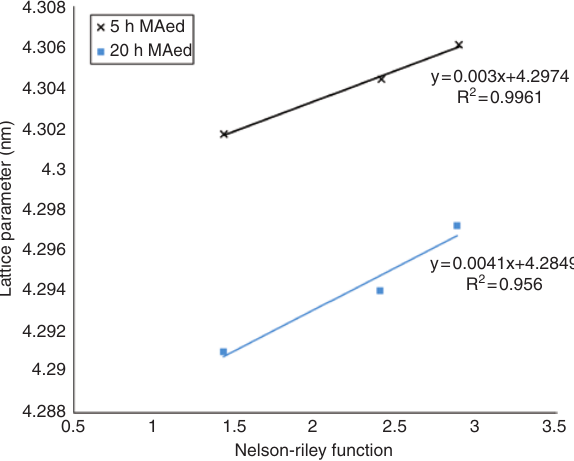
Figure 8: Changes of the lattice parameter in TiC system based on the Nelson-Riley function in the milling times of 5 and 20 h.